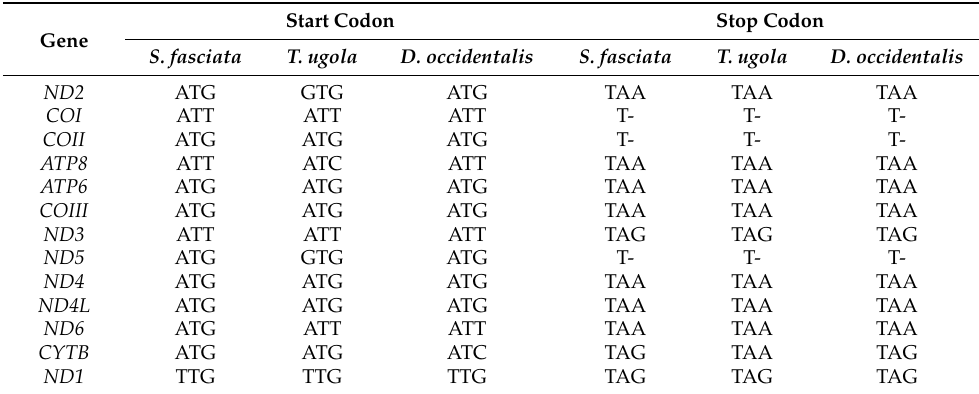
Table 3. Start and stop codons of three taeniopterygid mitogenomes.